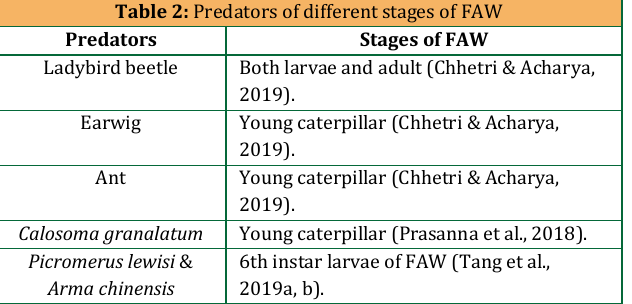
Table 2: Predators of different stages of FAW Predators Stages of FAW